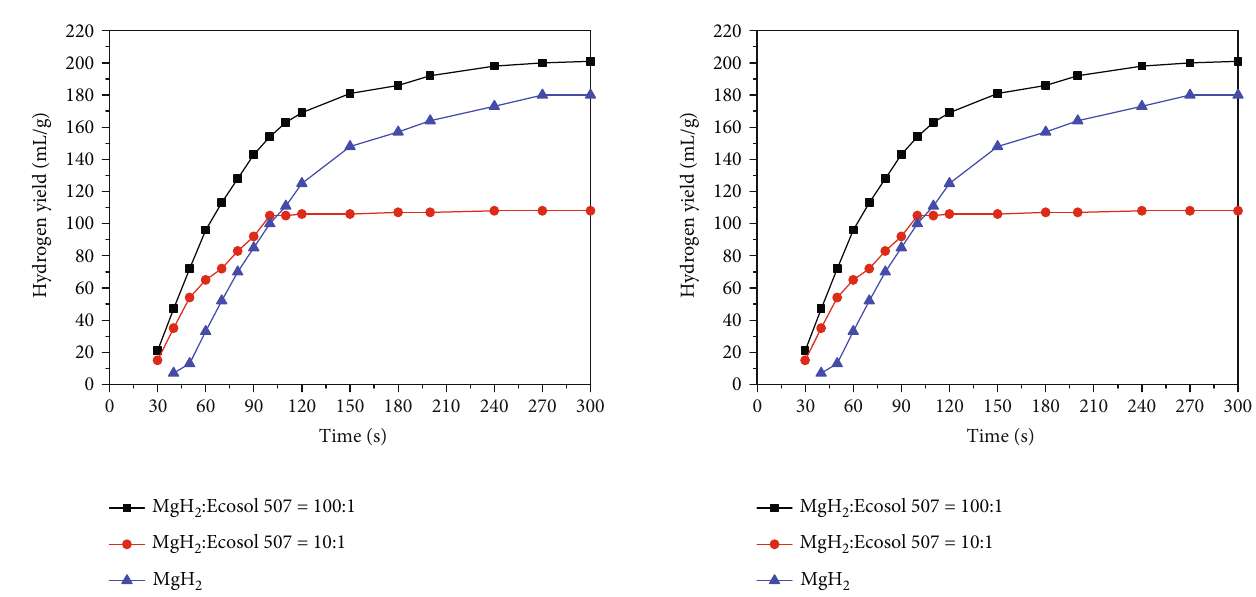
Figure 7: The e ff ect of di ff erent Ecosol 507 dosages on hydrogen generation. Table 5: Surface tension values of aqueous solutions with di ff erent Ecosol 507 dosages. Ratio ST (mN/m) Water 71.57 MgH :Ecosol 507=100 :1 28.38 2